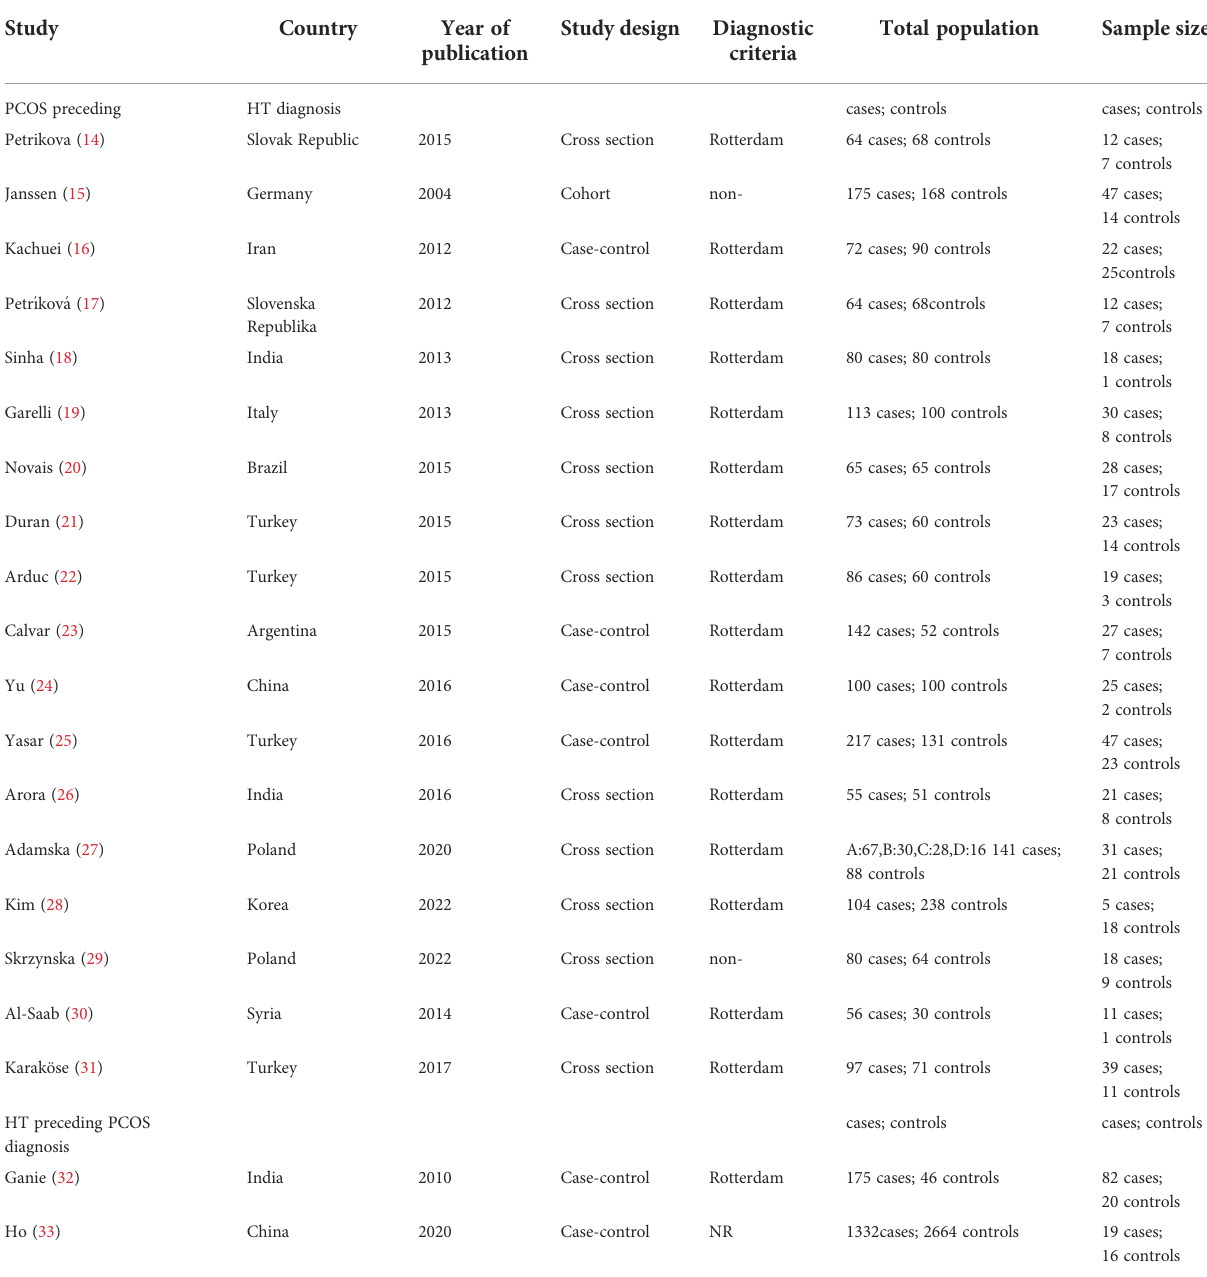
TABLE 1 Characteristics of included